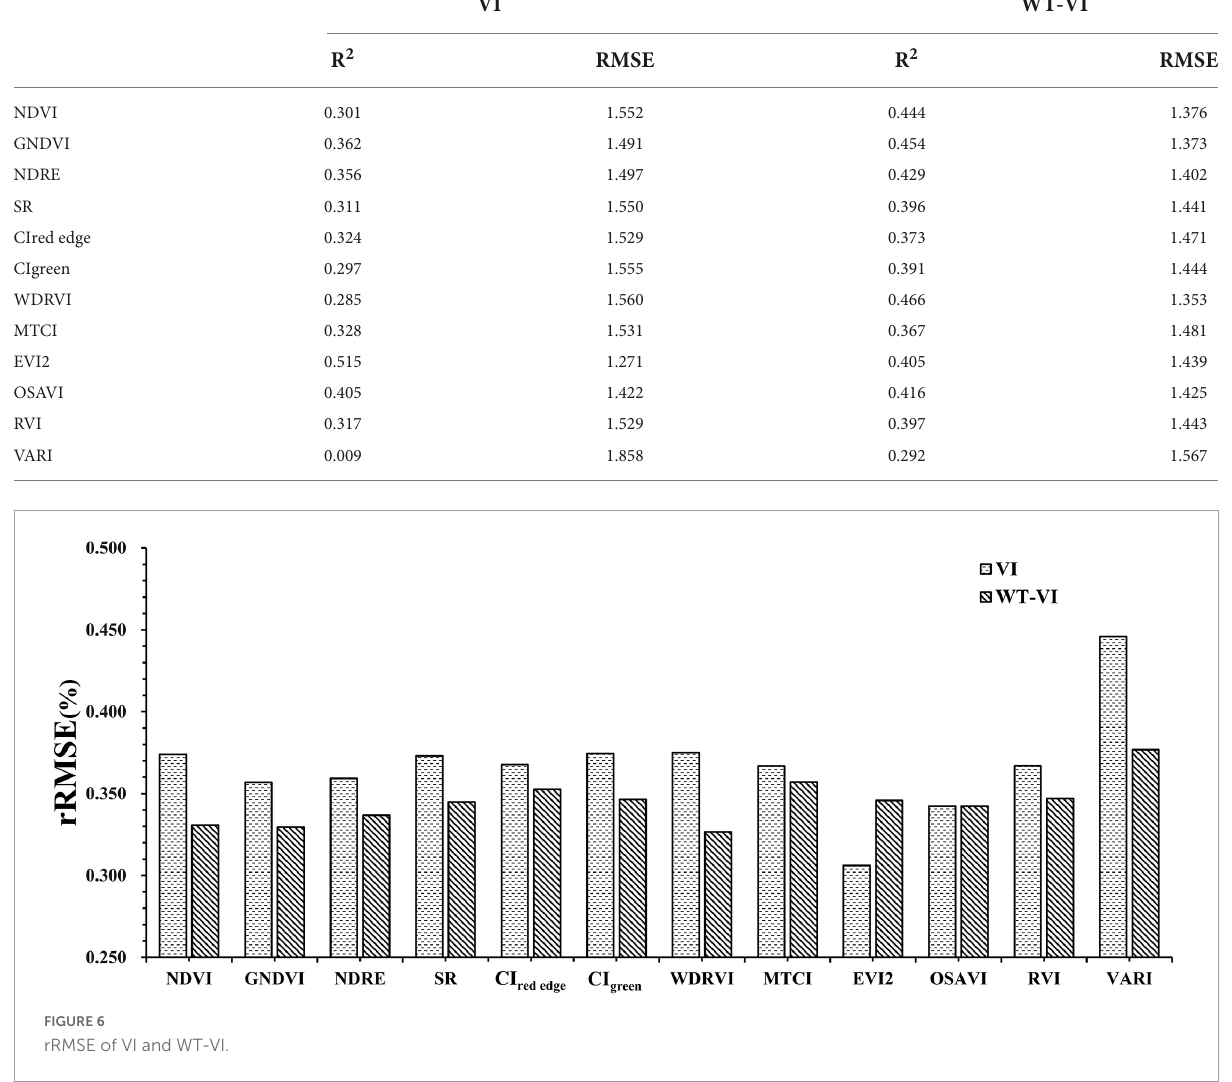
FIGURE6 rRMSE of VI and WT-VI.